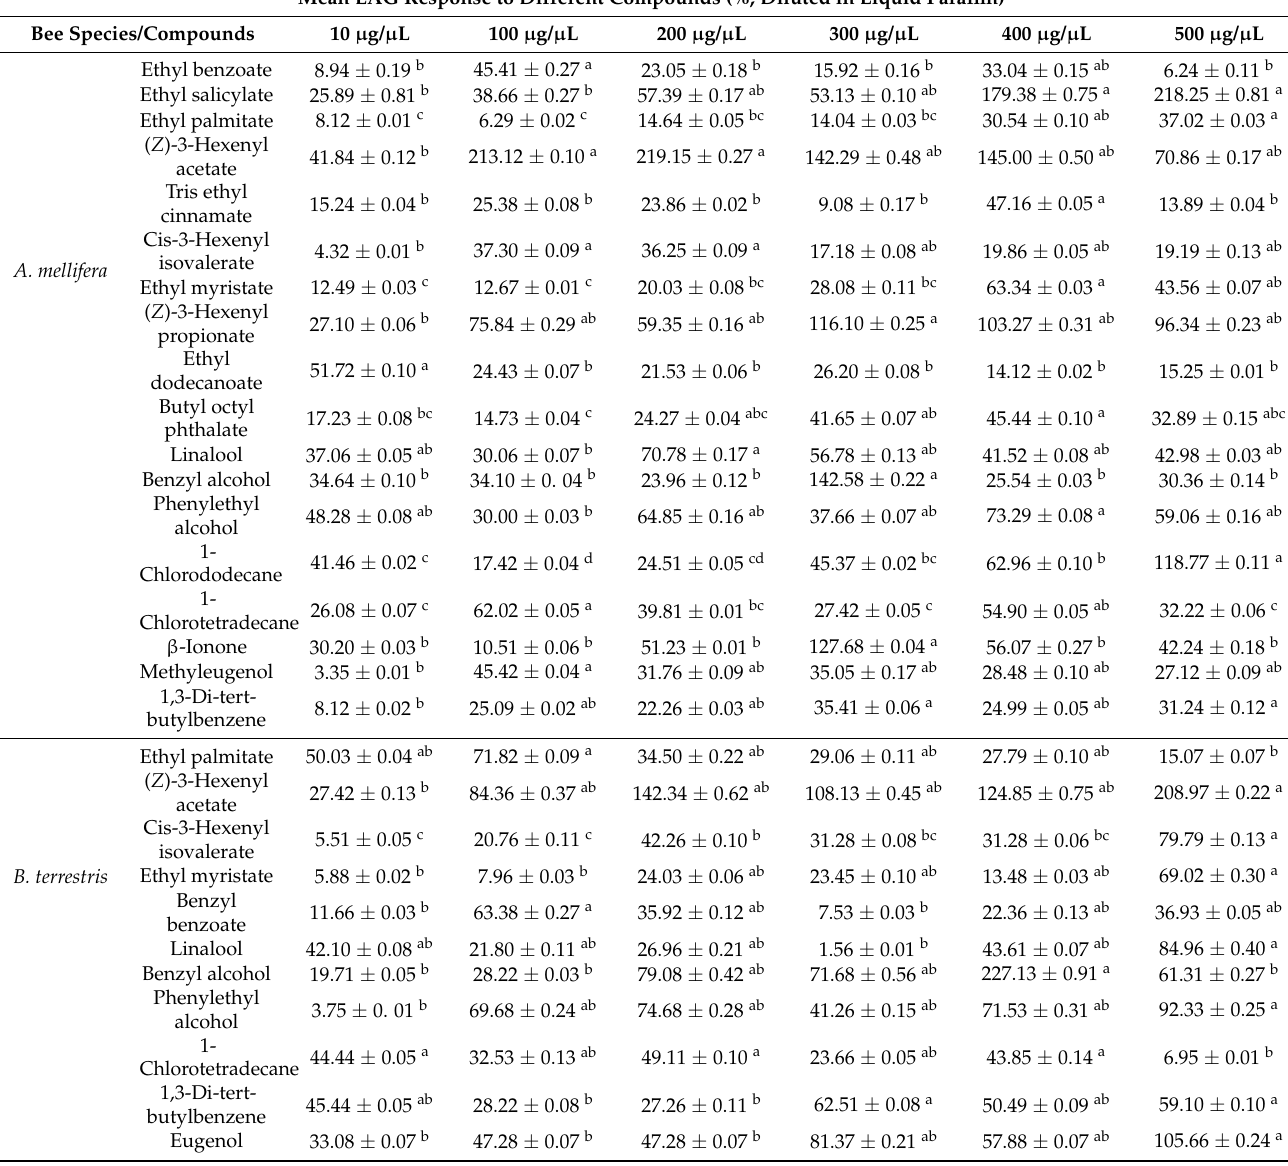
Table 3. Significant differences in EAG responses (mean ± sem.) to different concentrations of the same compound of A. mellifera and B. terrestris